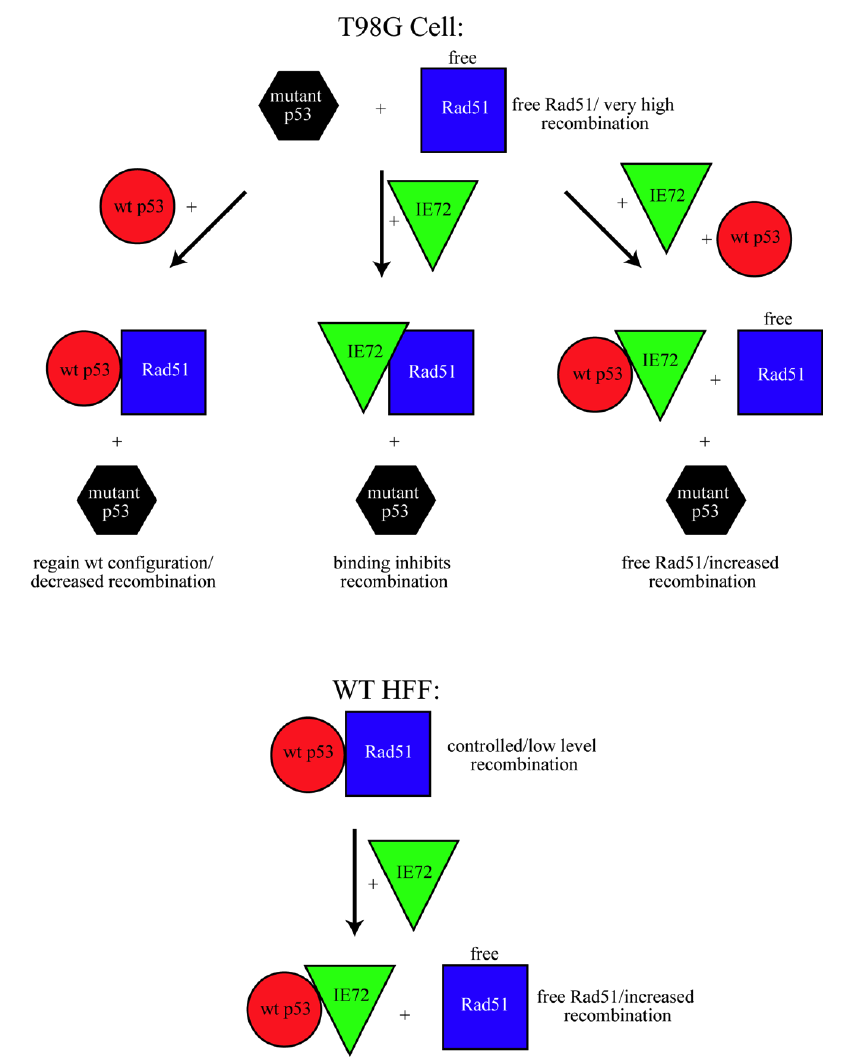
Figure 5. A model for the interactions between wt p53, Rad51 and IE72 in HFFs and T98Gs. Interactions between these three proteins and the ramifications to HDR depend completely on the cellular microenvironment and the presence or absence of wt p53. See text for